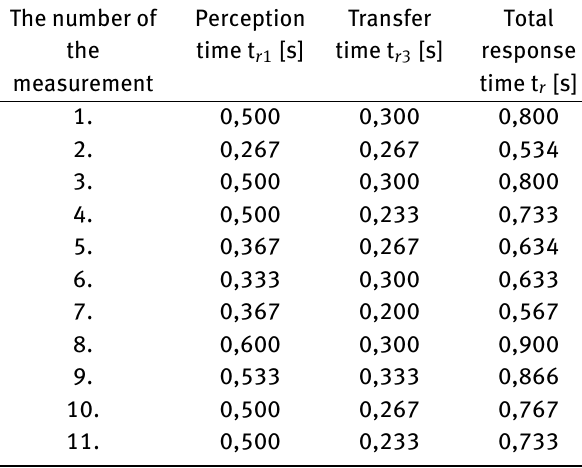
Table 6: Summary of the results of driver A. The number of the measurement